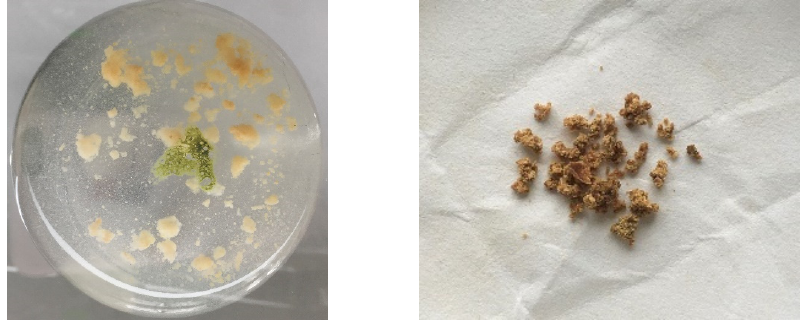
Figure 2. Suspension cells and dry biomass of giao co lam , elicited with 100 μ M SA after 6 days of culture.